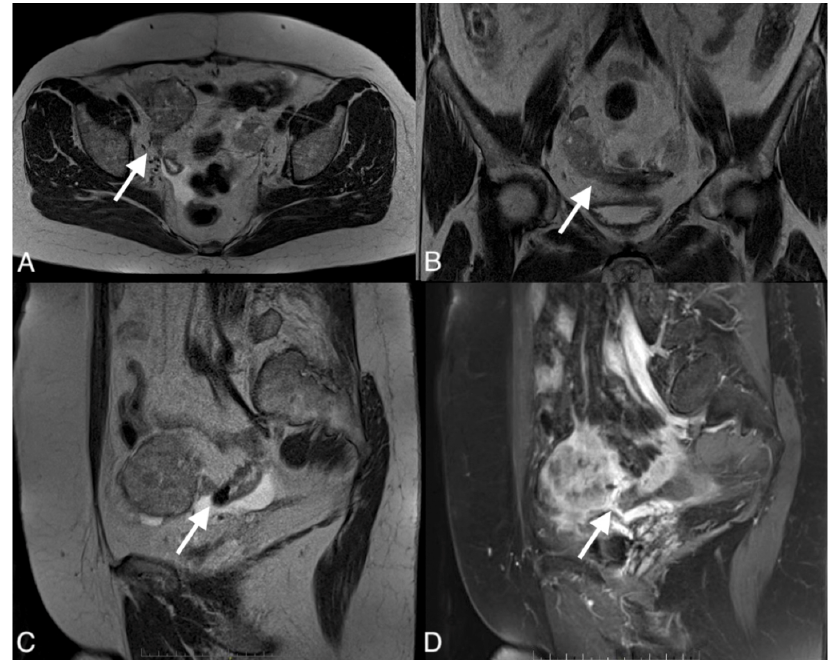
Figure 5. Images of a 67-year-old woman with a recurrent high grade serous ovarian cancer. MRI T1-weighted post-contrast image obtained in the axial plane ( A ), coronal plane ( B ), sagital plane ( C ), and T1-weighted image post-contrast ( D ) show large pelvic tumor and fistula (arrows) between the tumor and sigmoid colon.